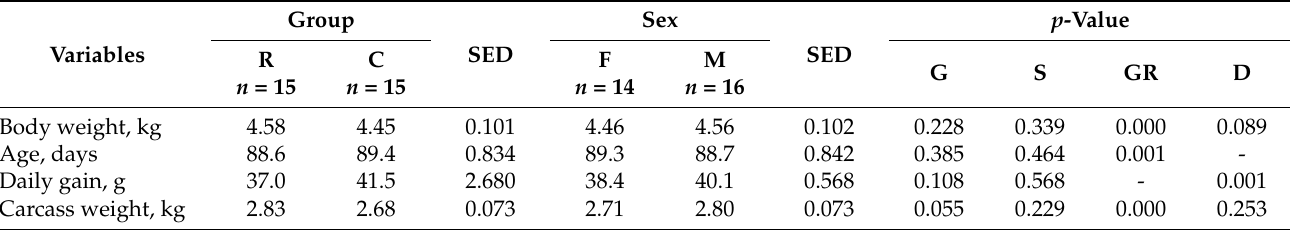
Table 2. Characteristics of geese used for meat quality